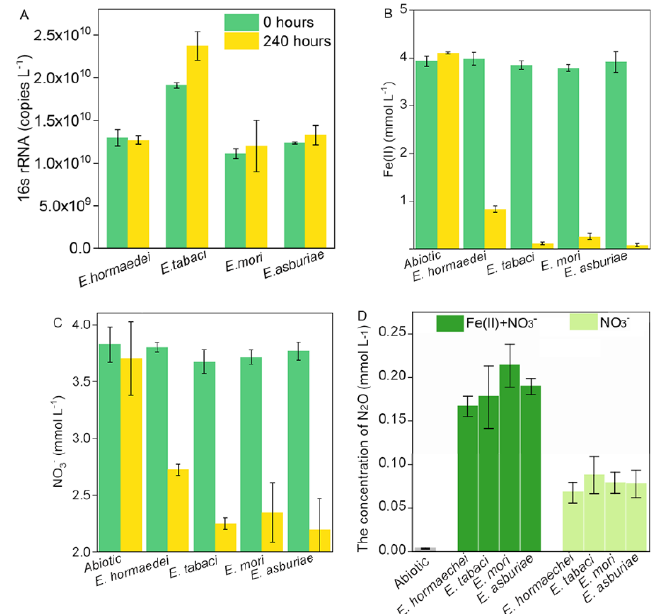
Figure 2. The ability of iron(II) oxidization and nitrate reduction by Enterobacter strains in the NRFO medium after 240 h of incubation. ( A ) The number of cells for Enterobacter strains in the NRFO medium. ( B ) The extent of iron(II) oxidation by Enterobacter strains in the NRFO medium during 10 − day incubation. ( C ) The extent of nitrate reduction by Enterobacter strains in the NRFO medium during 10 − day incubation. ( D ) The concentration of N 2 O in the NRFO medium after 10 − day incubation. “Fe(II)+NO 3 − ” and “NO 3 − ” indicated the medium containing with and without iron(II) during the incubation.